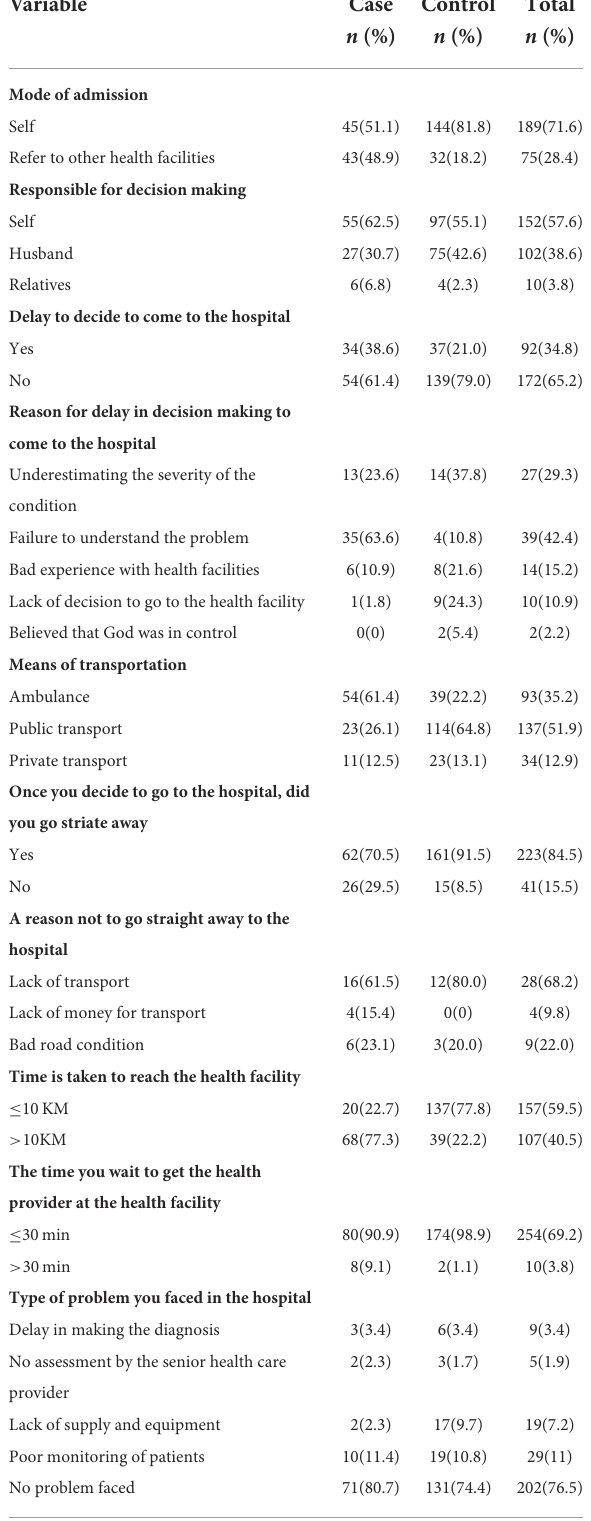
TABLE 4 Patterns of the three delays for maternal health care among mothers admitted to public hospitals of North Shewa Zone, Ethiopia, 2020 (N =